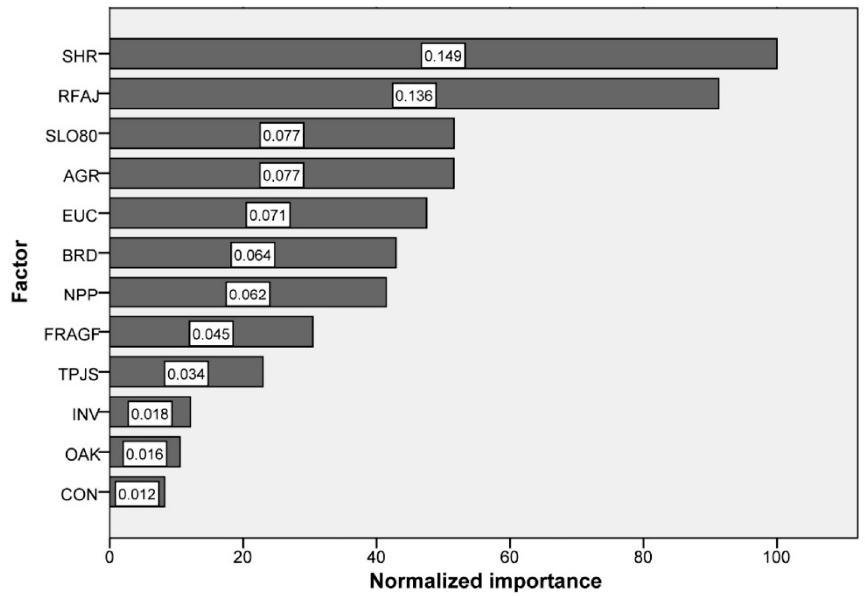
Figure 5. Importance of each biophysical driver for the classification tree model, shown normalized by the most important driver (SHR).